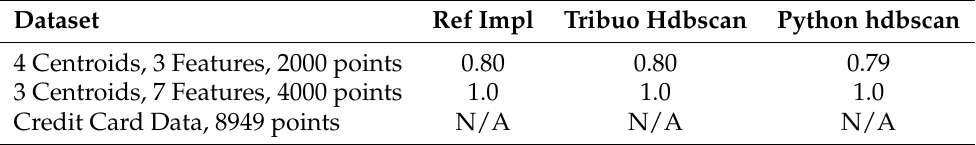
Table 3. The adjusted mutual information scores of the cluster assignments for trained